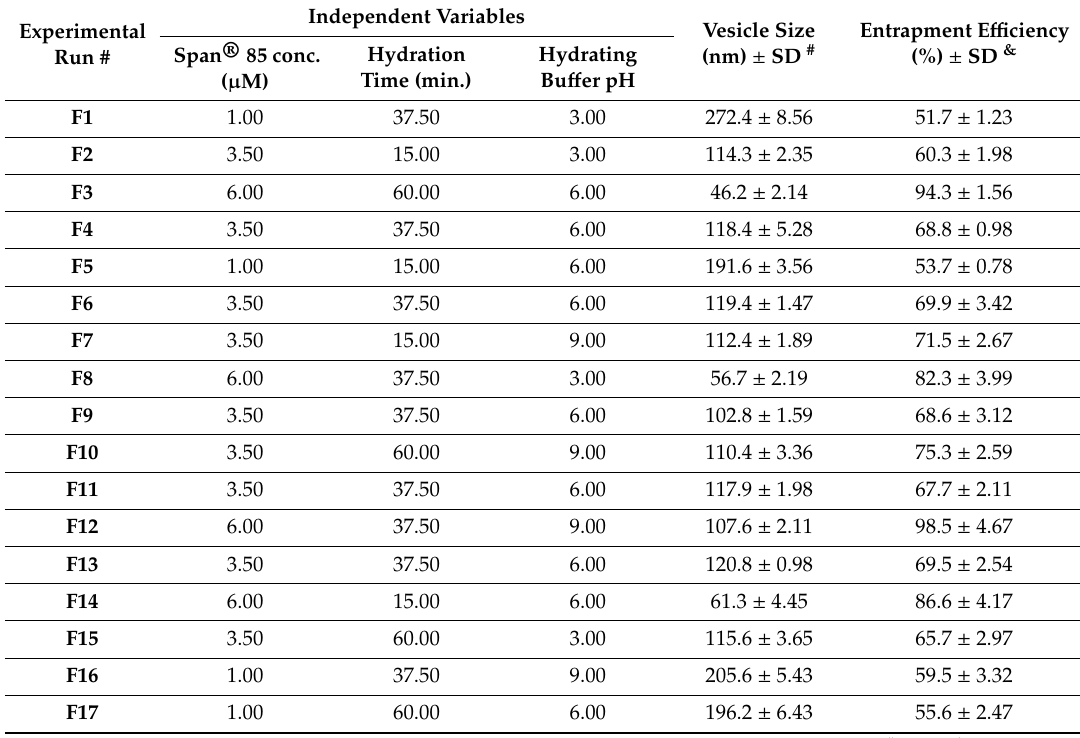
Table 2. Experimental runs, variables levels, and observed responses of FLB niosomes prepared according to the Box–Behnken design.